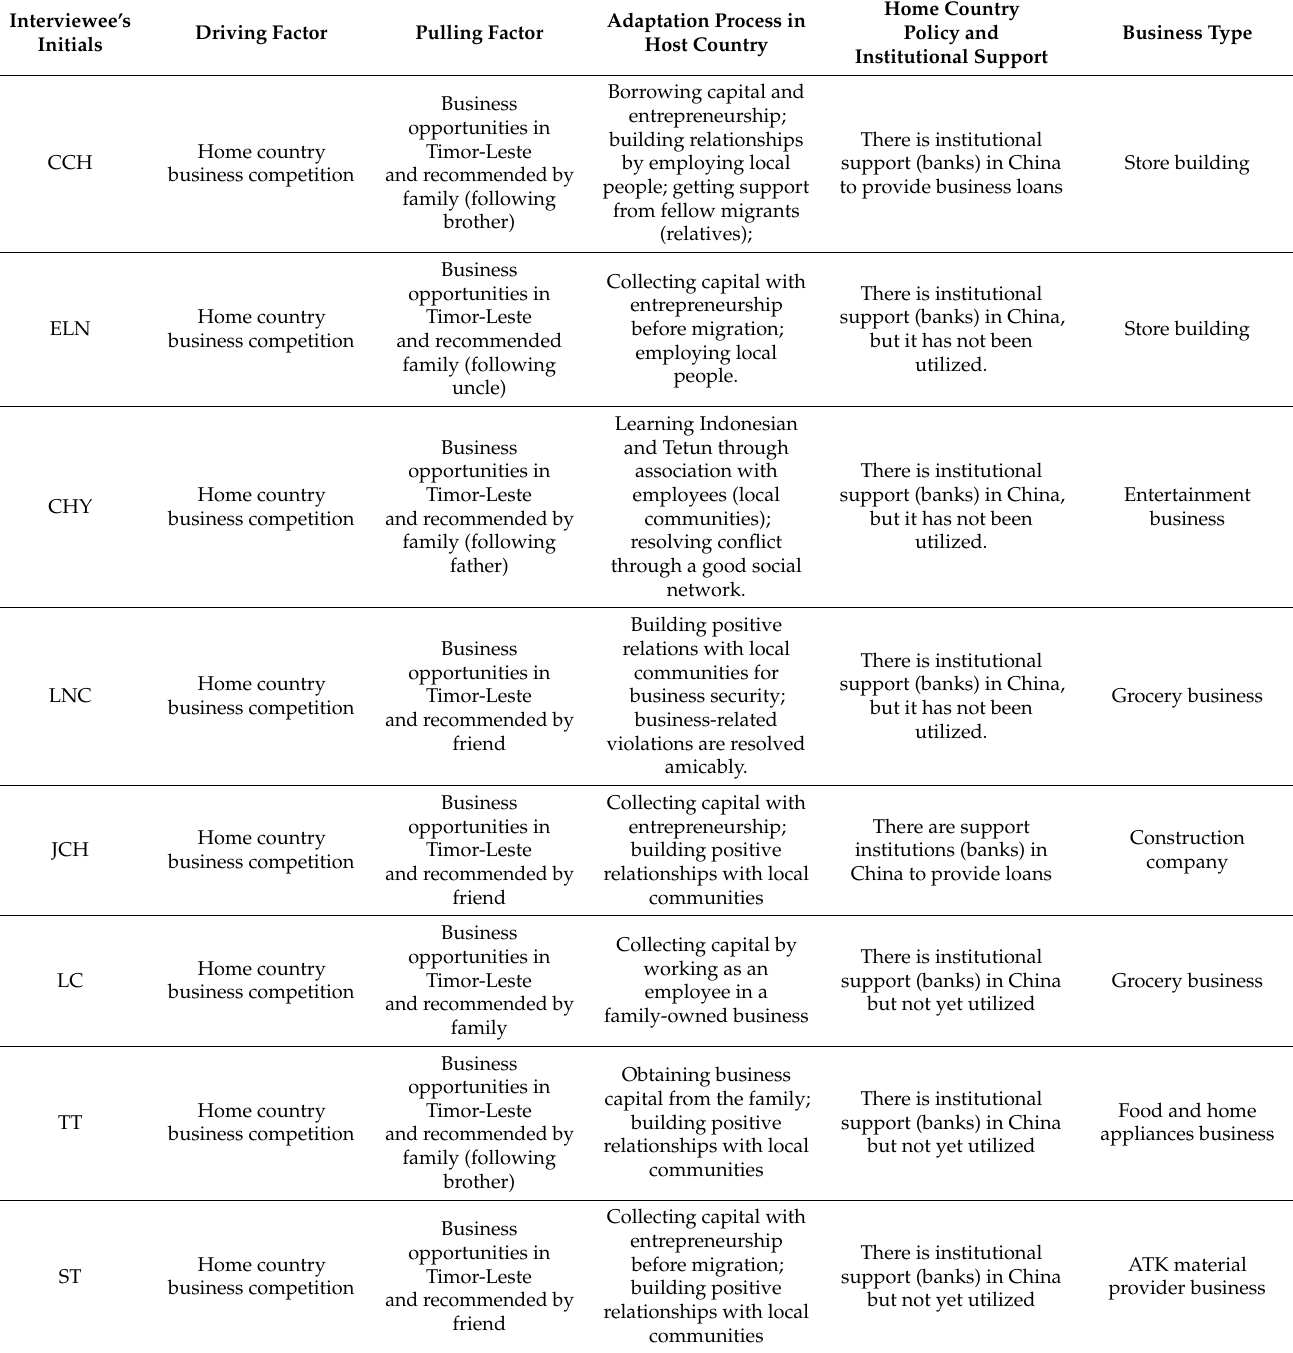
Table 1. Push and pull aspects of